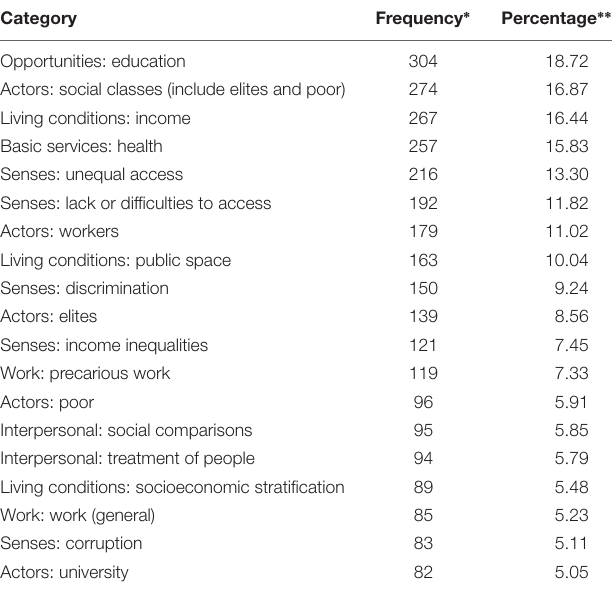
TABLE 3 | Frequencies and percentages of responses coded in each